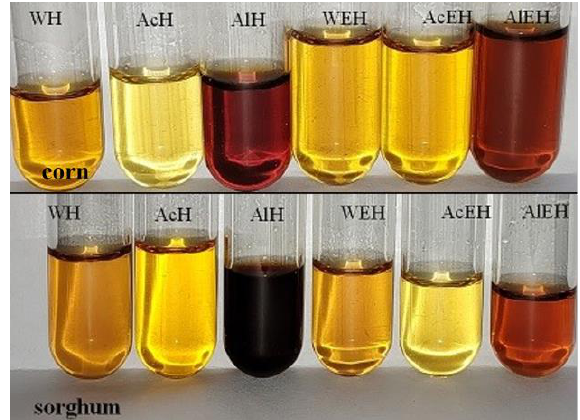
Figure 1. Photos of hydrolysate samples of CS and SS.